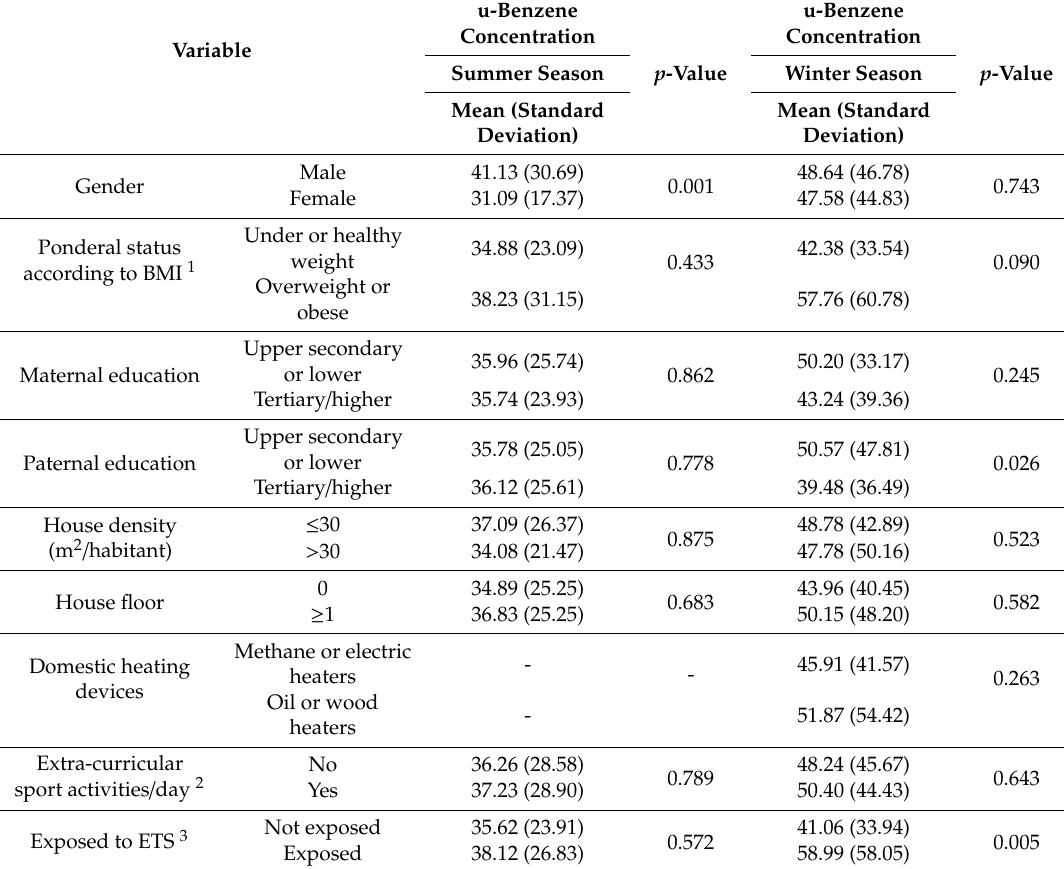
Table 3. u-Benzene concentrations (ng L − 1 ) according to some characteristics of participants, of their parents and of their living